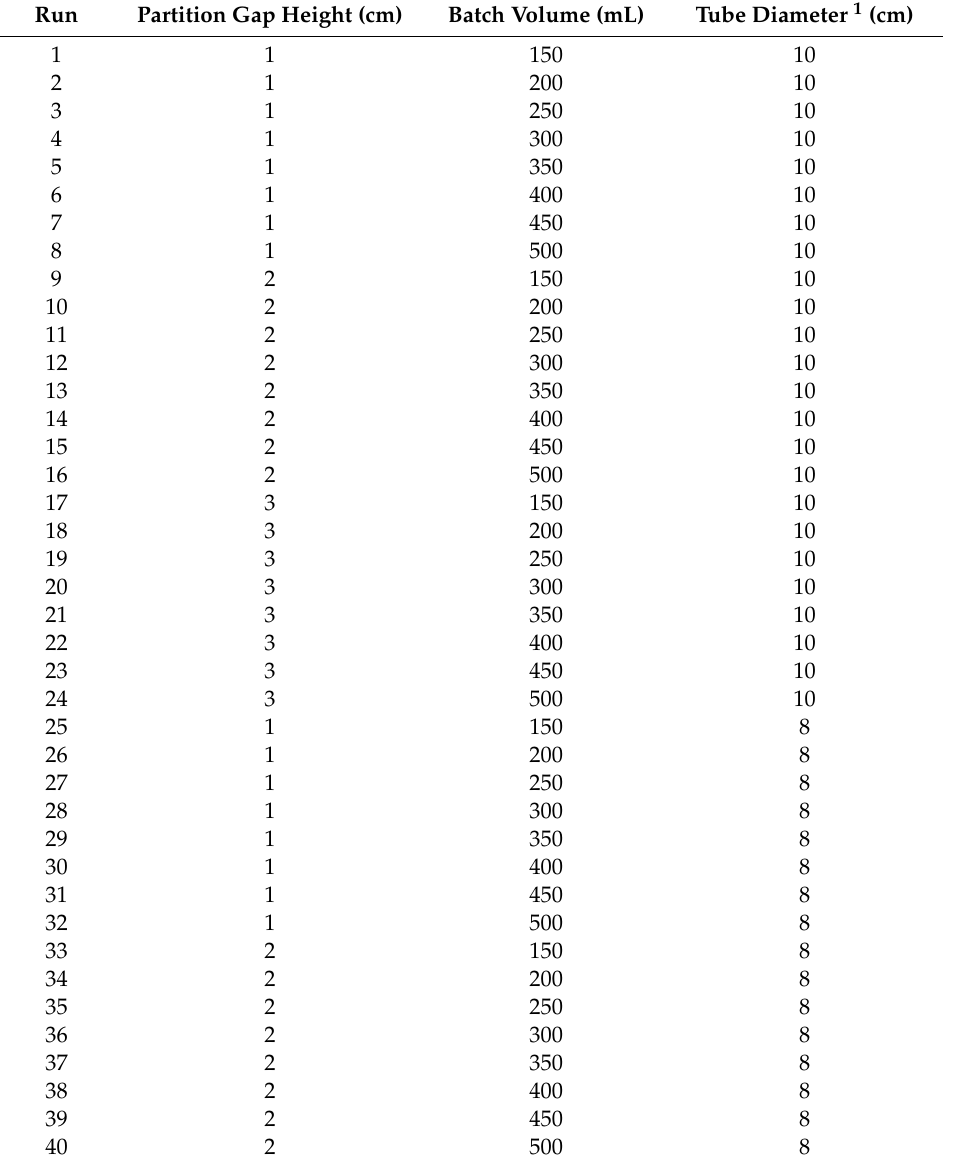
Table 2. Design and process parameters for superficial velocity